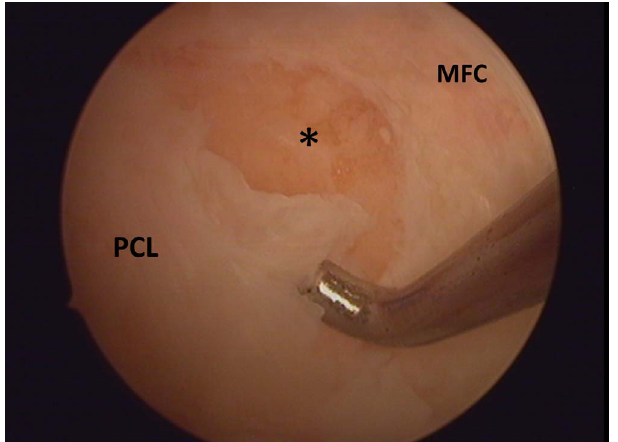
Figure 4. Case 2. AP and oblique views with ossi fi cation in the intercondylar notch area, one year following the initial